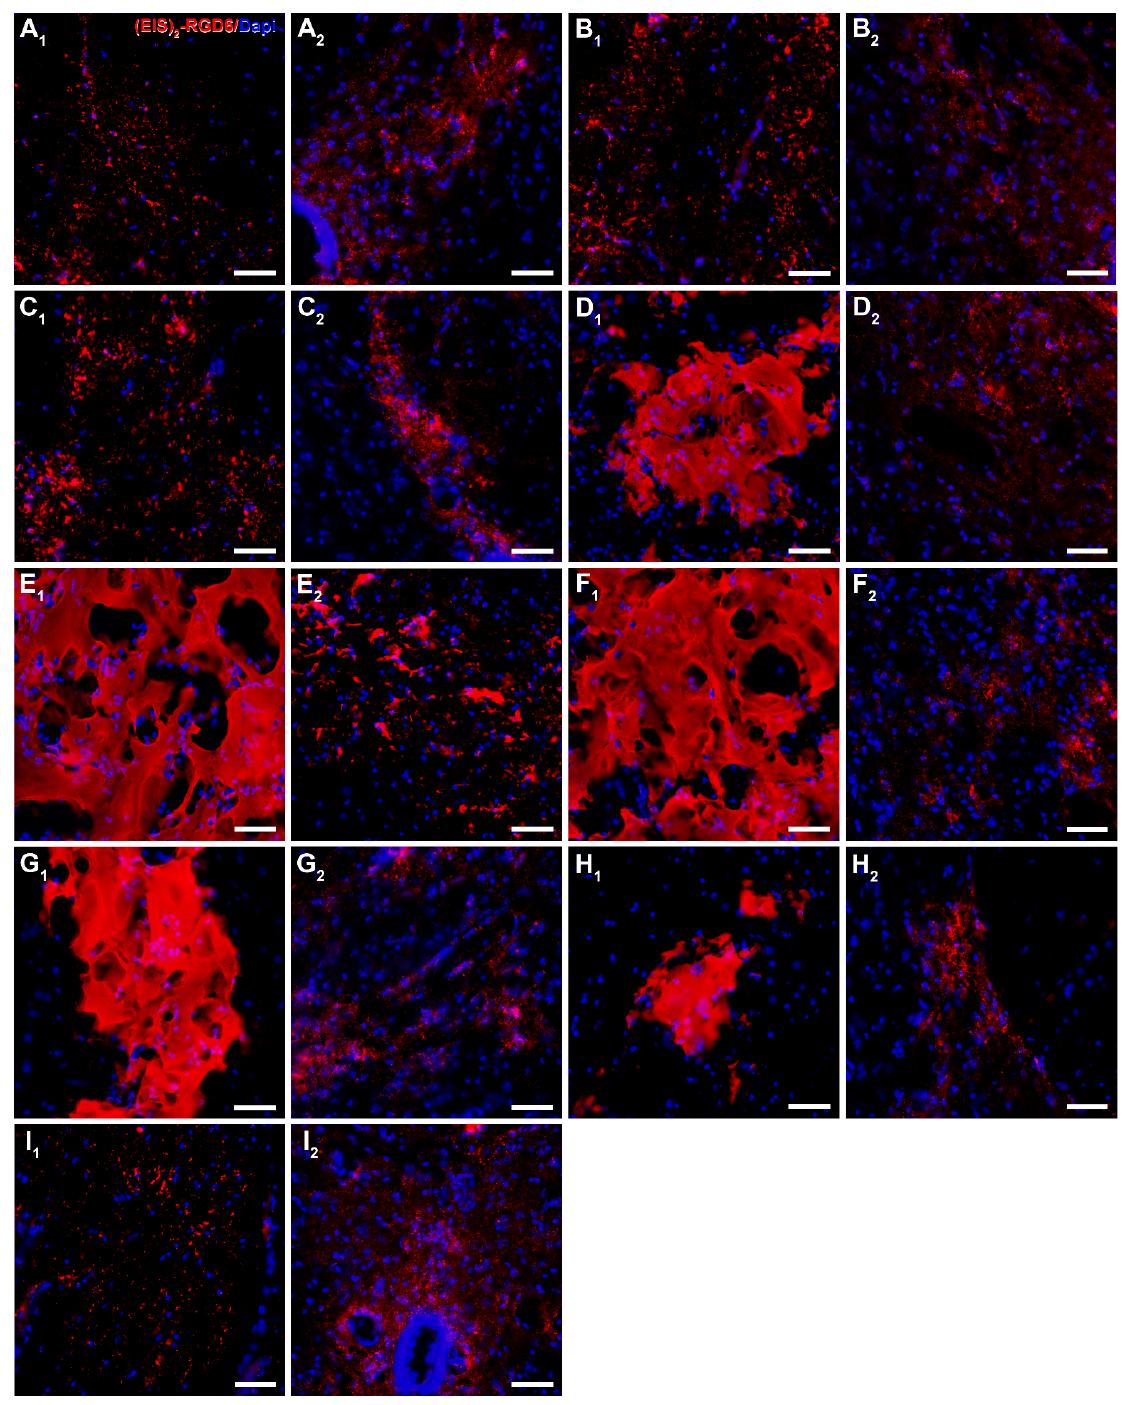
Figure 11. Qualitative microscopic analysis of (EIS) 2 -RGD6 structure at 1 day post-injury. Representa- tive higher magnification images of spinal cord sections processed for the visualization of biotinylated (EIS) 2 -RGD6 at 1 day post-injury [experiment (EIS) 2 -RGD6 II], showing (EIS) 2 -RGD6 structure at the following representative rostro-caudal spinal cord levels: ( A 1 , A 2 ) 7.2 mm rostral; ( B 1 , B 2 ) 5.4 mm rostral; ( C 1 , C 2 ) 3.6 mm rostral; ( D 1 , D 2 ) 1.8 mm rostral; ( E 1 , E 2 ) 0 mm; ( F 1 , F 2 ) 1.8 mm caudal; ( G 1 , G 2 ) 3.6 mm caudal; ( H 1 , H 2 ) 5.4 mm caudal; and ( I 1 , I 2 ) 7.2 mm caudal from the injury epicentre. Scale bars, 50 µ m. Please note that the specific areas shown in these images are highlighted in Figure